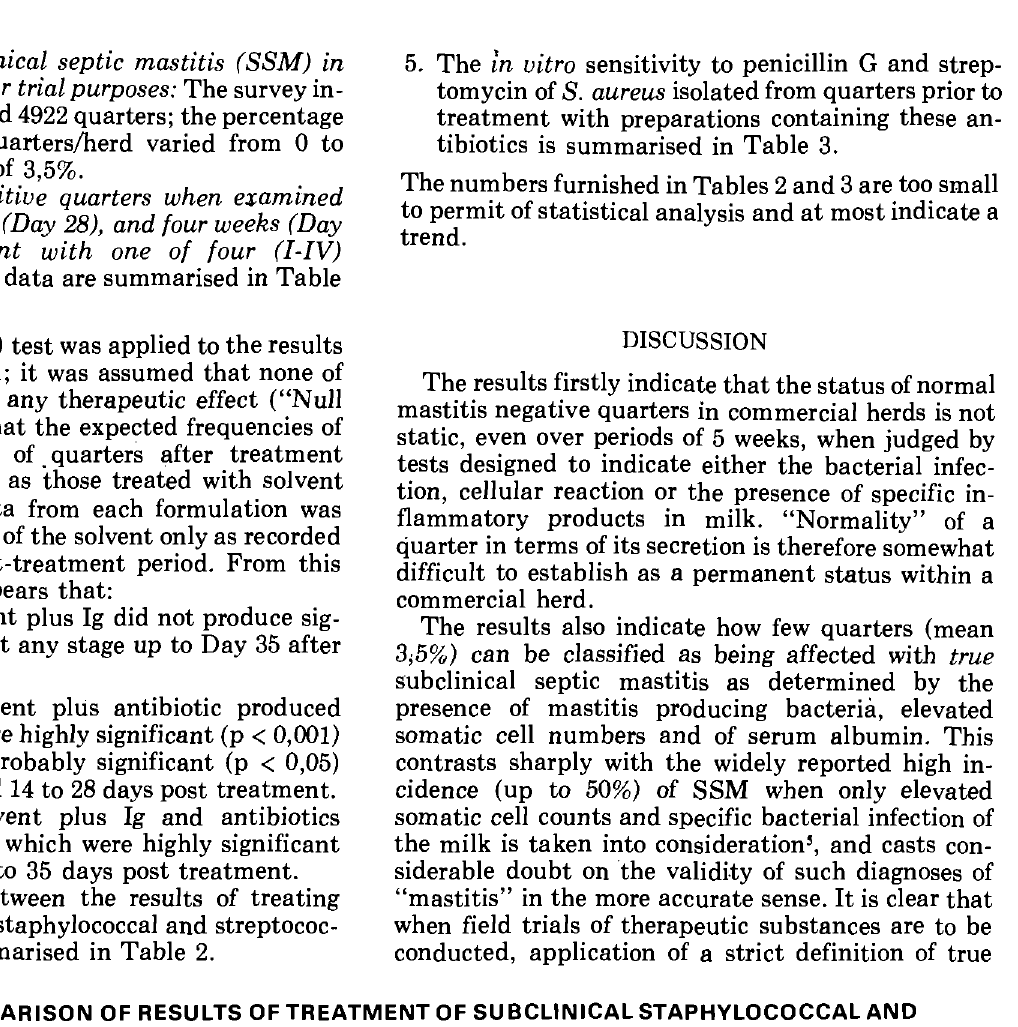
Table 2: COMPARISON OF RESULTS OF TREATMENT OF SUBCLINICAL STAPHYLOCOCCAL AND STREPTOCOCCAL MASTITIS WITH FORMULATIONS I-IV